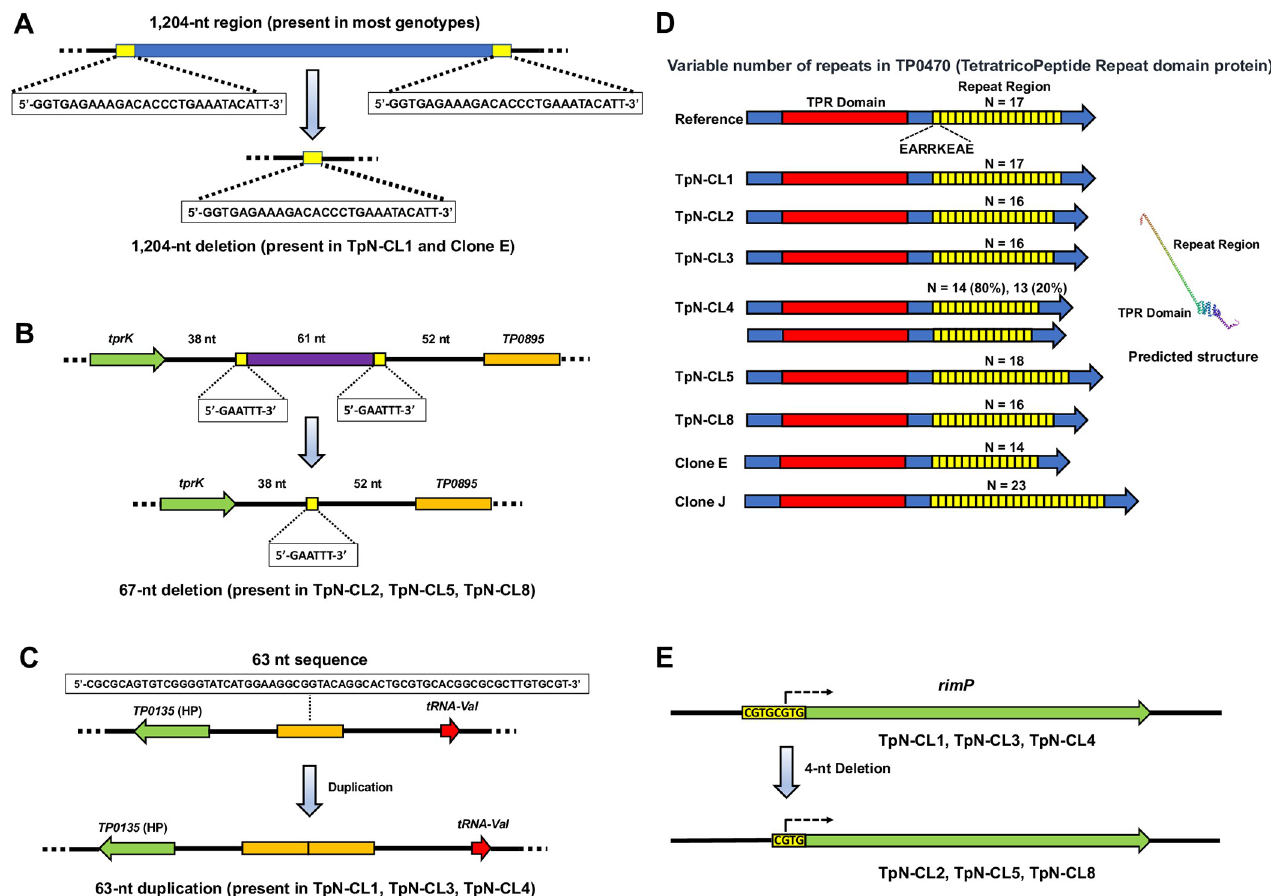
Fig 4. Insertions and deletions present in the T . pallidum Nichols genome. (A) A 1,204 nt deletion present in TpN-CL1 and T . pallidum Nichols Clone E (CP010560.1), resulting from recombination between two 33-nt direct repeats. (B) Deletion of a 67-nt region downstream of tprK ; the deleted region is flanked by a 5-nt direct repeat. (C) Duplication of a 63-nt intergenic region near TP0135 . (D) Occurrence of varied number of 24-nt repeats with TP0470 ; the inset shows the predicted structure of the TP0470 protein product. (E) A 4-nt indel at the beginning of TP0893 ( rimP ) that may alter its promoter and RBS spacing, but does not change the start